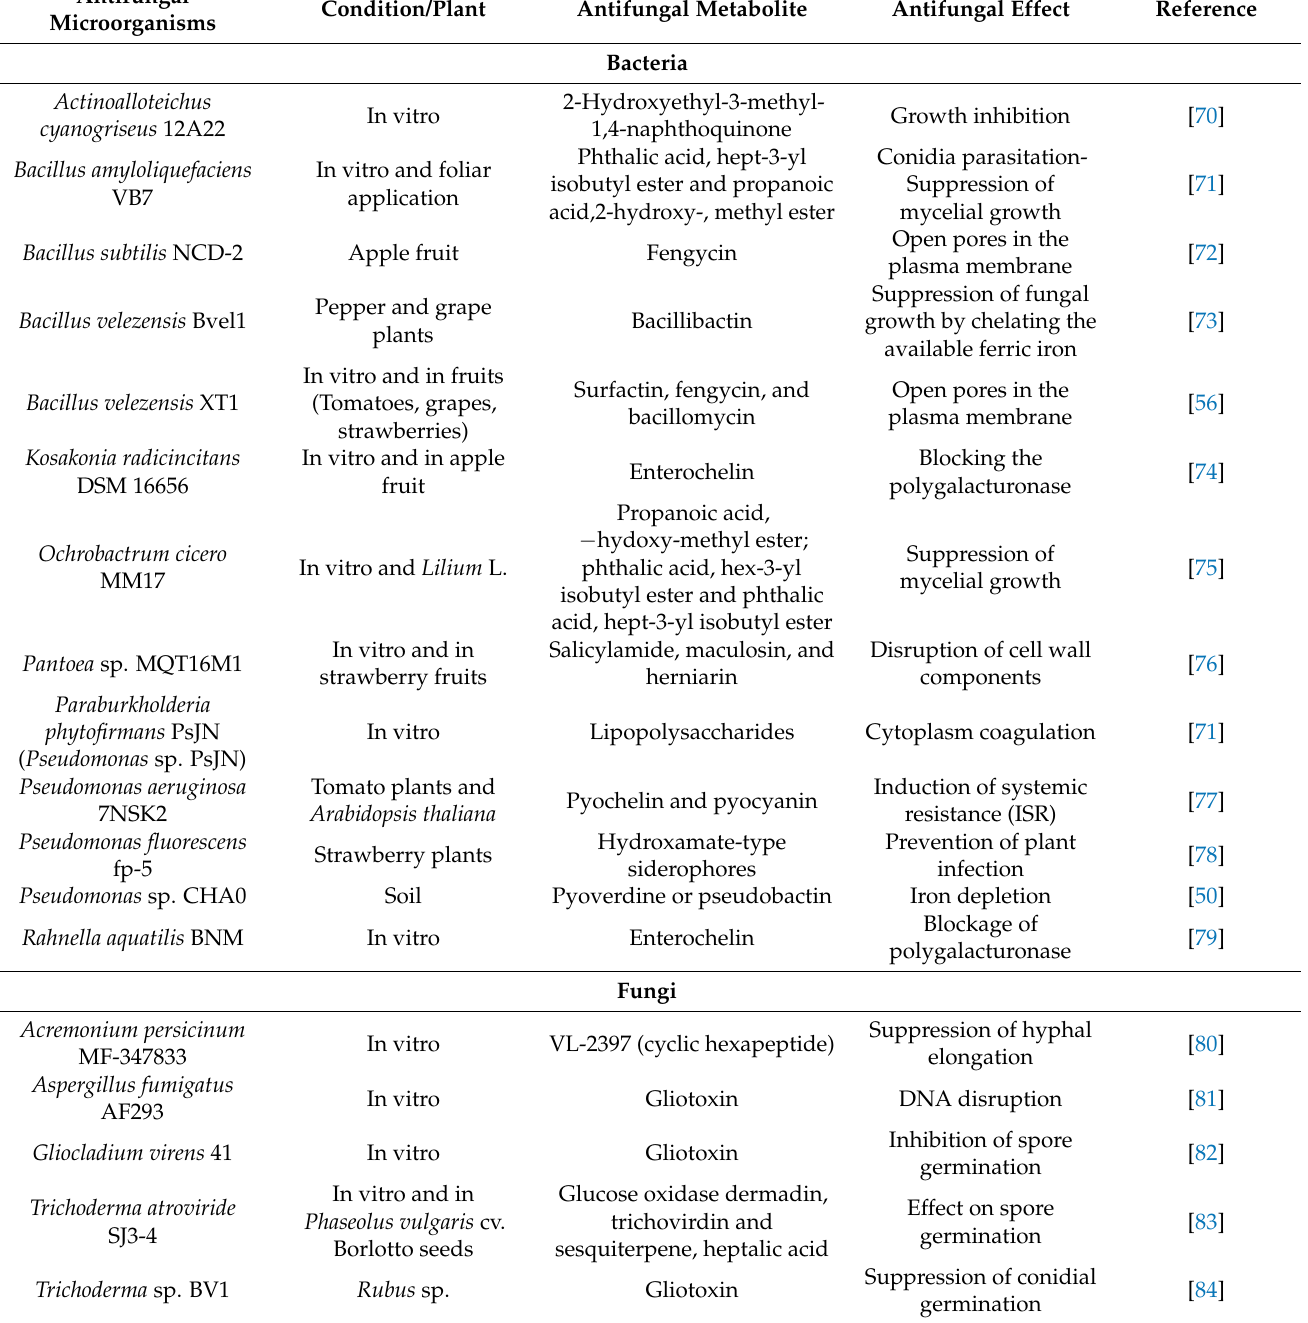
Table 1. Overview of literature reporting the inhibition of Botrytis cinerea through the production of diffusible antifungal